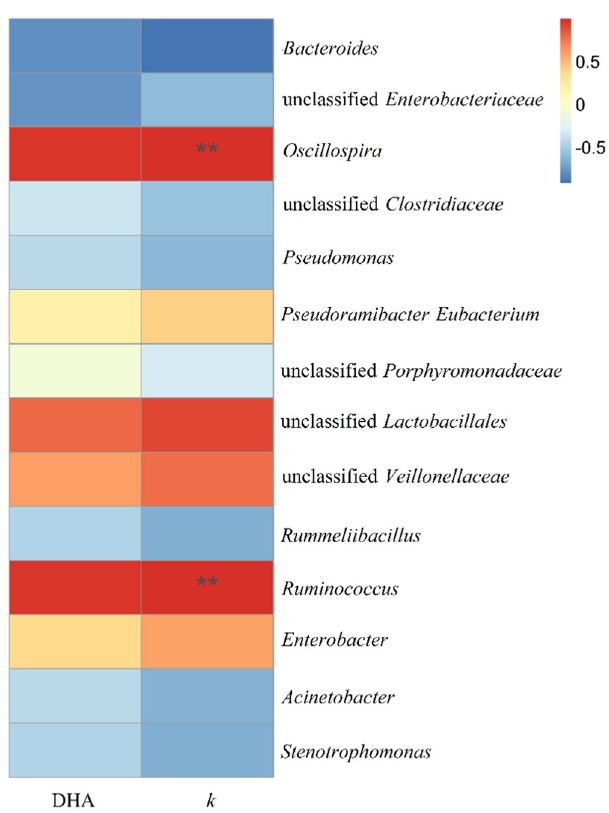
Figure 8. The heatmap shown the correlation between the abundance of bacteria at the genus level and two factors in the C 0 , CA and CAQ systems. Spearsman’s correlation was applied to assess the relationship between the main microorganisms and factors. ** Indicates that p < 0.01. (Abbreviations: DHA, dehydrogenase activity; k, rate constant of 2-CA